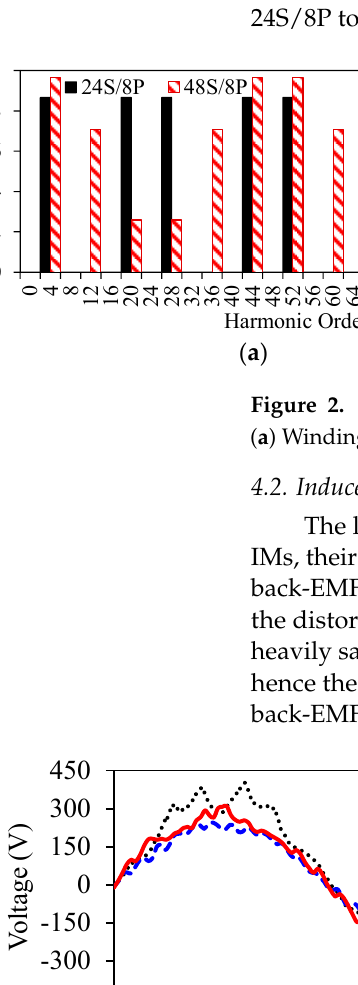
Figure 1. Two-dimensional views of the compared machines: ( a ) IPM (48S/16M/8P). ( b ) CIM (48S/52R/8P). ( c ) AIM (24S/26R/8P).